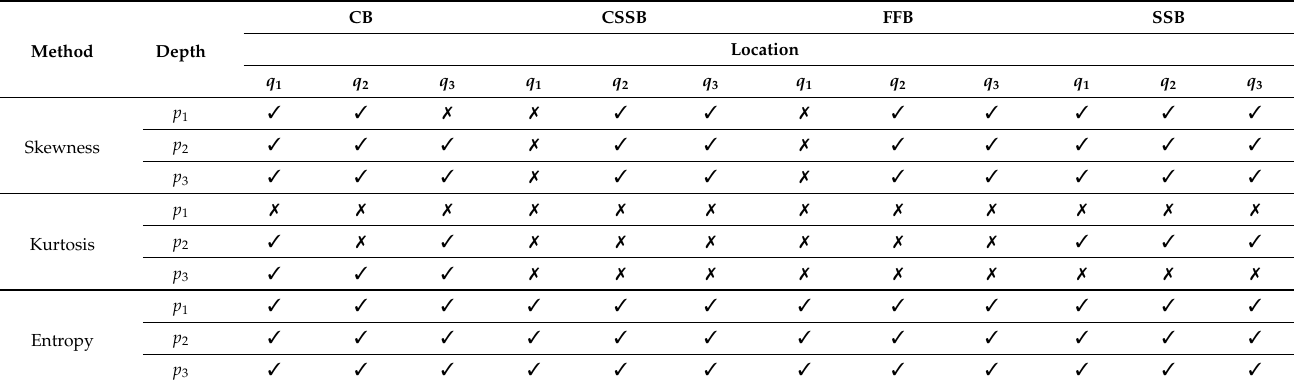
Table 2. The effectiveness of proposed methods for locating a single breathing crack for a variety of damage scenarios with different depths, locations, and boundary conditions.